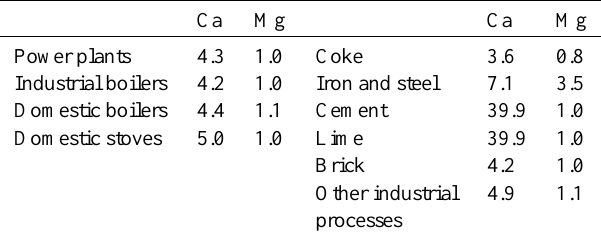
Table 7. Mass ratio of Ca and Mg to TSP from different emission sources, numbers show as